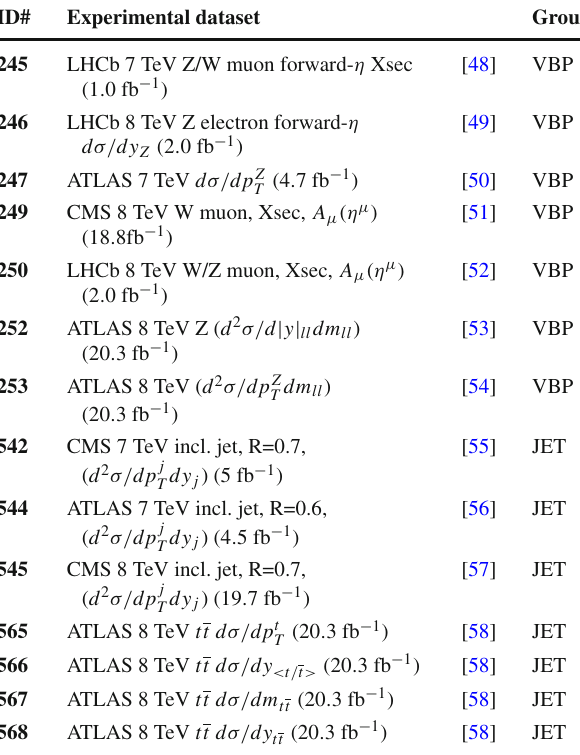
Table 4 Same as Table 3, but showing experimental datasets not incor- porated in the CT14HERA2 fit but included in the augmented CTEQ-